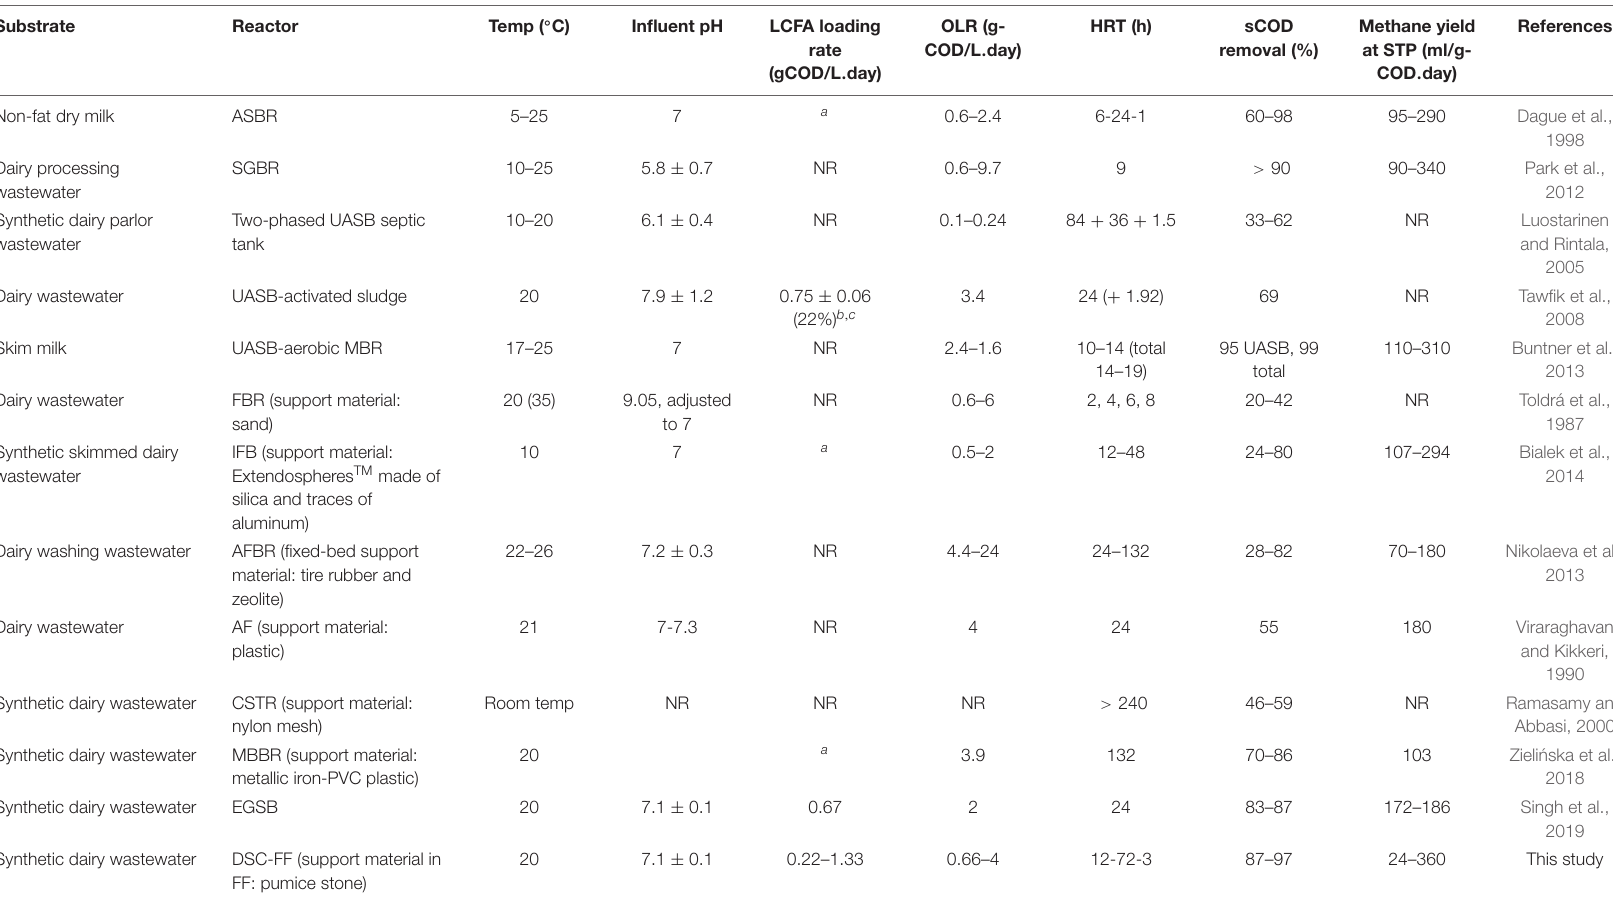
TABLE 1 | Process performance of anaerobic dairy wastewater treatment in adhered-film and granular sludge reactors at psychrophilic and low ambient temperatures.